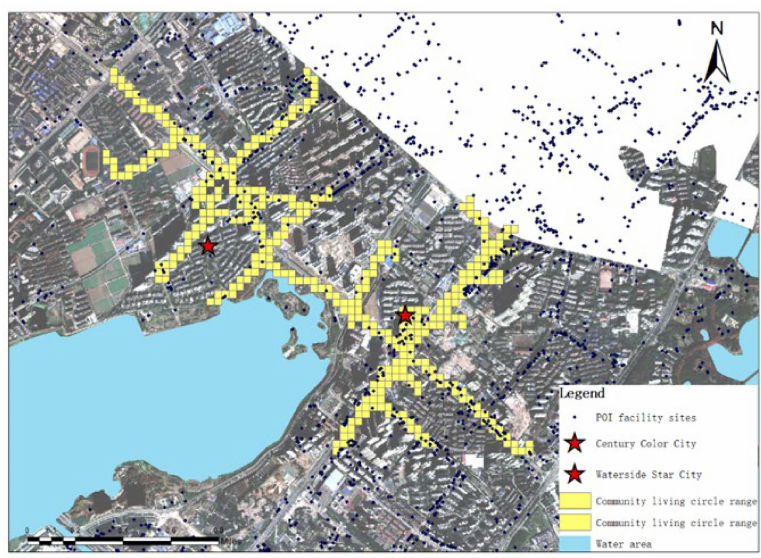
Figure 9. Coverage sharing diagram.